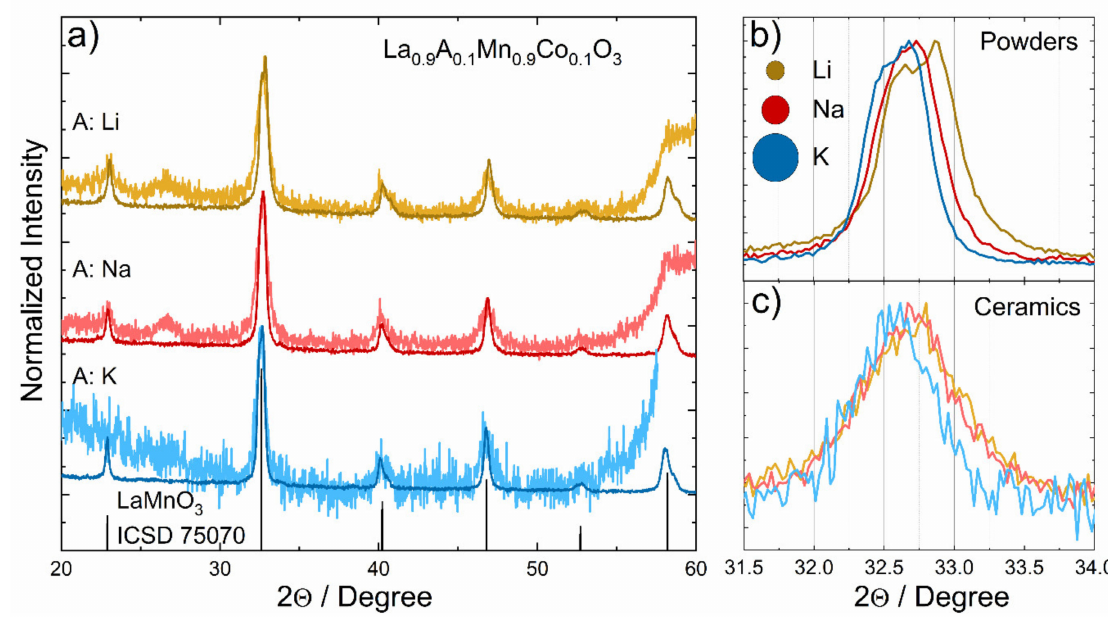
Figure 1. XRD patterns recorded for La 0.9 A 0.1 Mn 0.9 Co 0.1 O 3 powders and ceramics ( a ). The right panel shows enlarged region of the pattern, with shift of the peak and with change of the dopant ionic radius observed in powders ( b ) and broadening of the peak observed for ceramics ( c